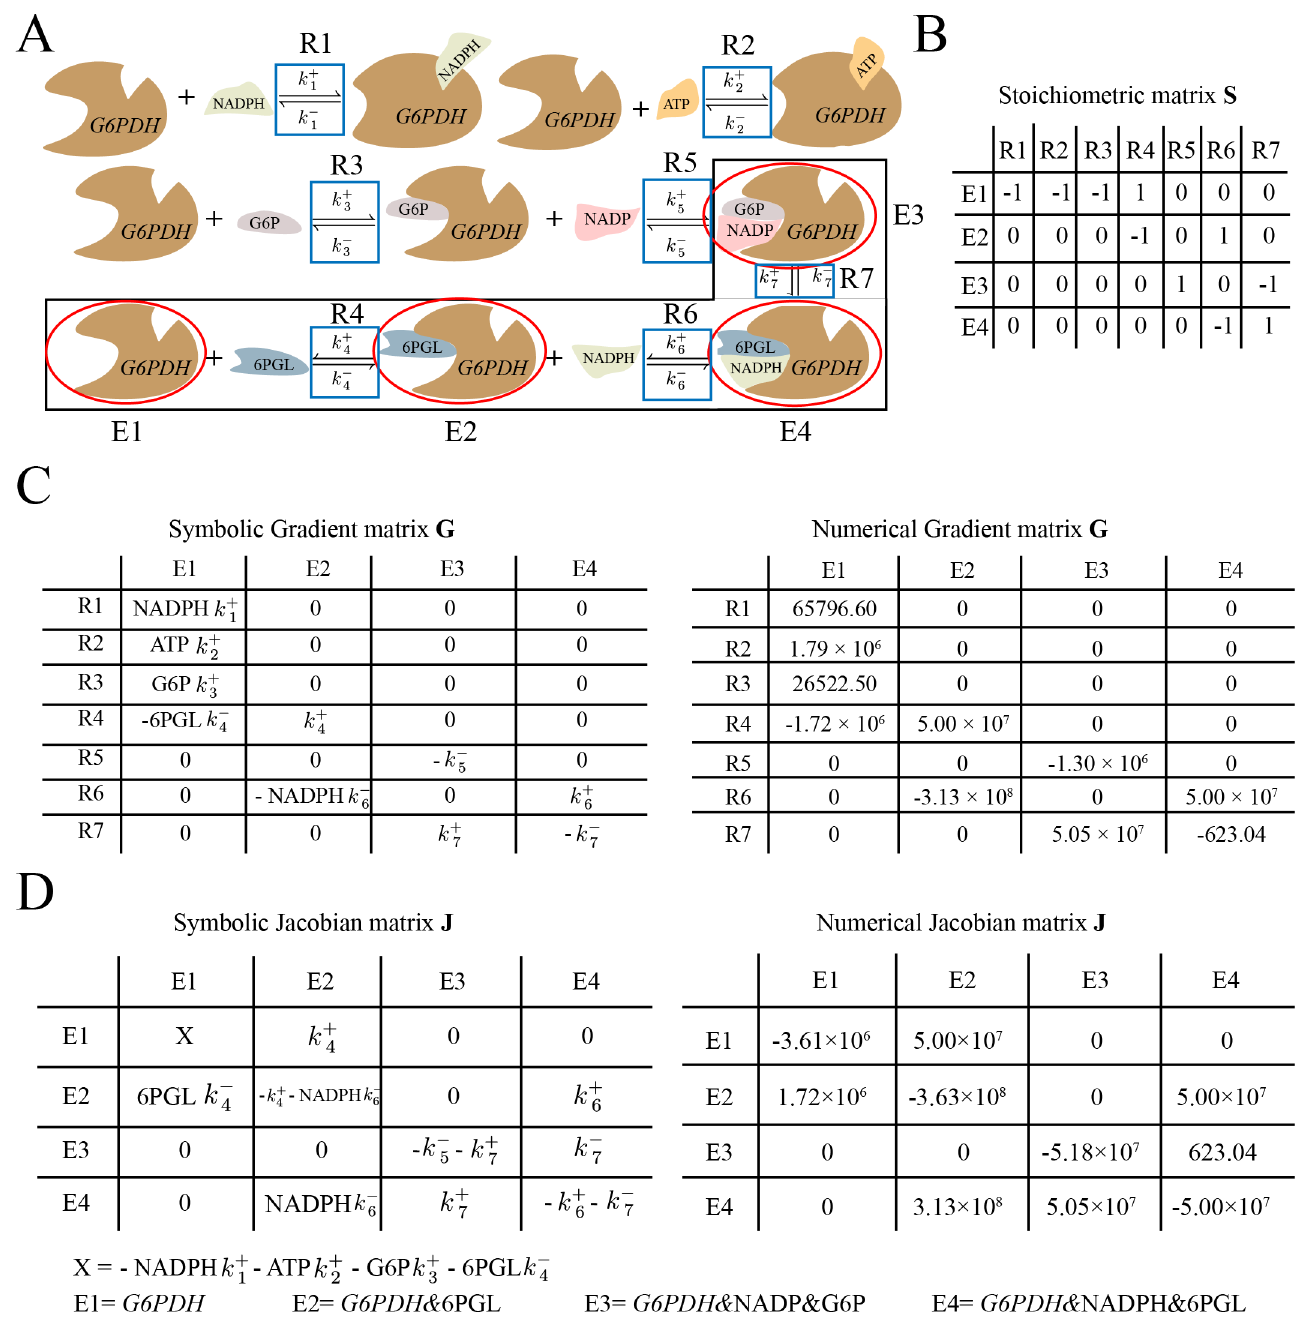
Fig 5. The origin of complicated mode structure associated with G6PDH enzyme forms demonstrated through the associatedmatrices. The mode structure containsfour enzyme forms (denoted as E1, E2, E3 and E4, full annotation at the bottom), with G6PDH &NADPH&6PGL and G6PDH &6PGL being the most dominant elements. We extracted the submatricesassociatedwith those four enzyme forms and their related reactions. We show that three key reactions and their associatedreactionsensitivitiesin G determine the mode structure. (A) The reactionsteps for the biochemicalreactioncatalyzed by G6PDH enzyme. The four dominant enzyme forms in the mode are labeledwith red circles. The reactions with their notations (R1 to R7) are labeledwith blue rectangular boxes. The three key reactions determining the mode structure are circle with black rectangularboxes. (B) The stoichiometric matrix S for the four enzyme forms in the mode and their associated reactions. The S matrix describesthe network topology of the enzyme forms and determines how they interact in the Jacobianmatrix. (C) The symbolic and numericalgradientmatrix G for the four enzyme forms in the mode and their associatedreactions. The key reactionsensitivitiesdetermining the two largest elementsin the mode are associatedwith reaction 6 and its correspondingenzyme forms. The key terms are k + 6 and NADPH k - 6 , which are similar in magnitude, due to the fact that NADPH concentration is similar to the equilibriumconstant of the half reaction for NAPDH binding/release. (D) The symbolic and